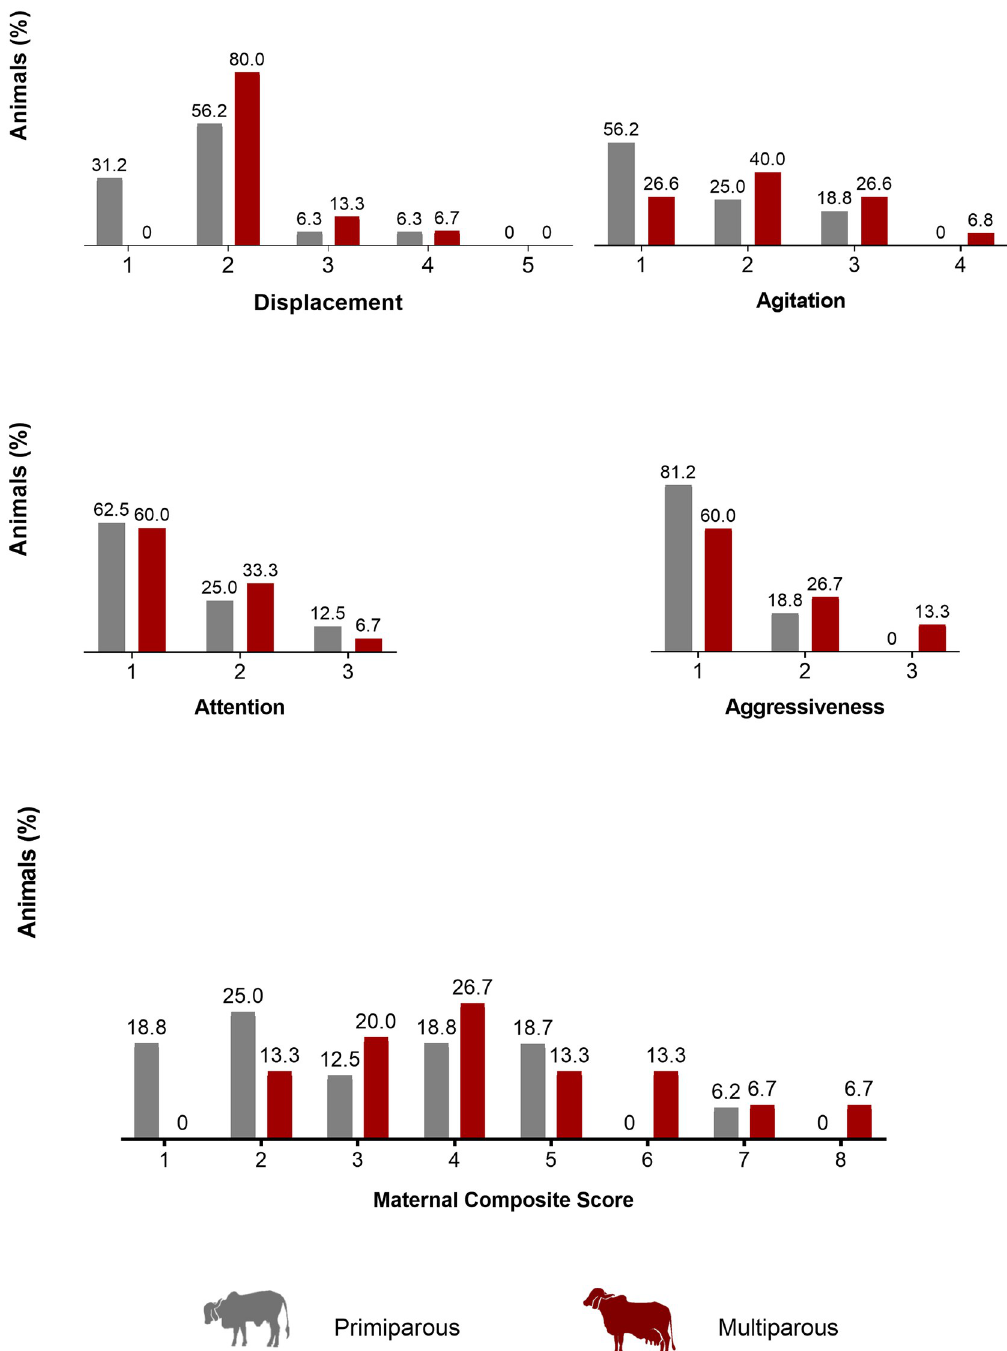
Fig 2. Maternal protection scoring system of primiparous and multiparous Gyr cows at the first handling of their calves (n = 31).